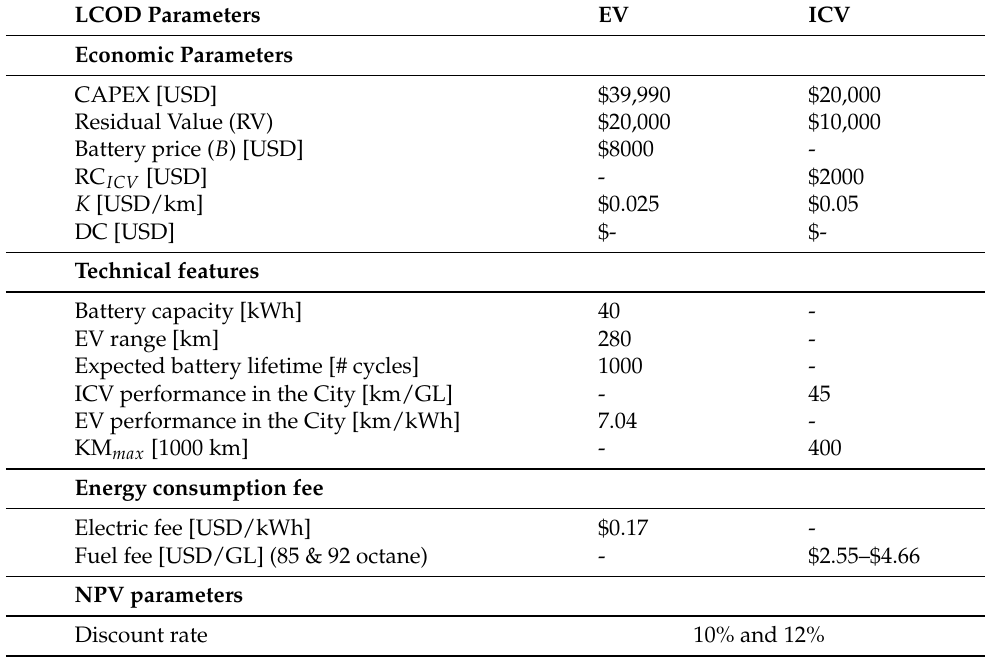
Table 2. Case study